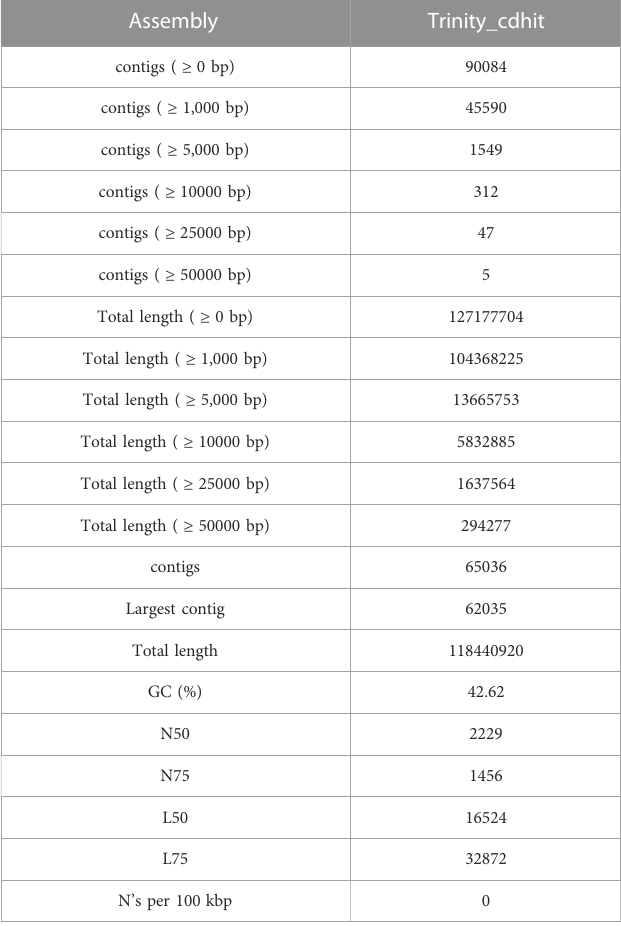
TABLE 1 Statistical summary of RNA-seq data used in this